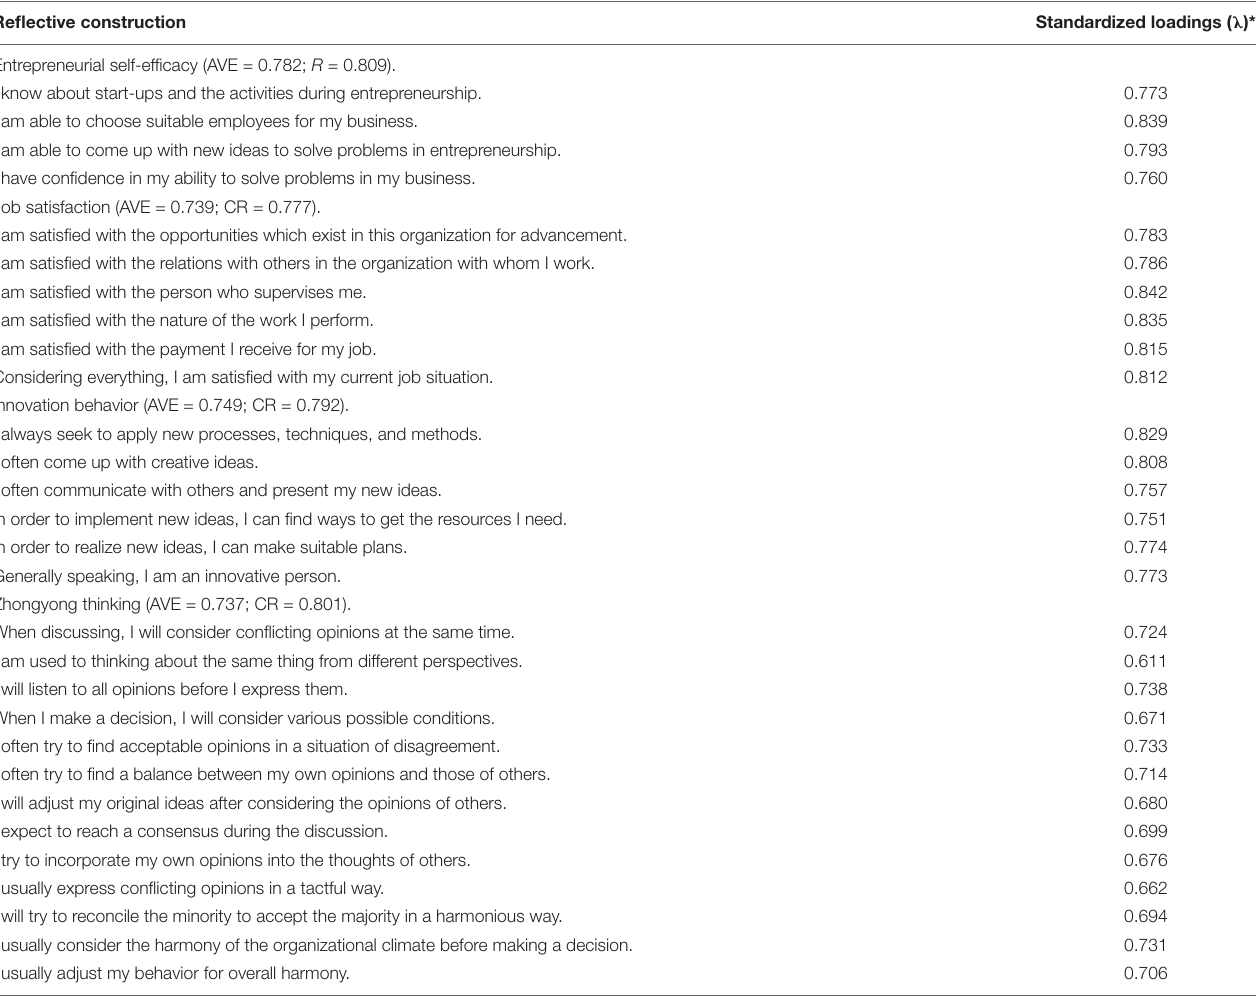
TABLE A1 | Measurement for